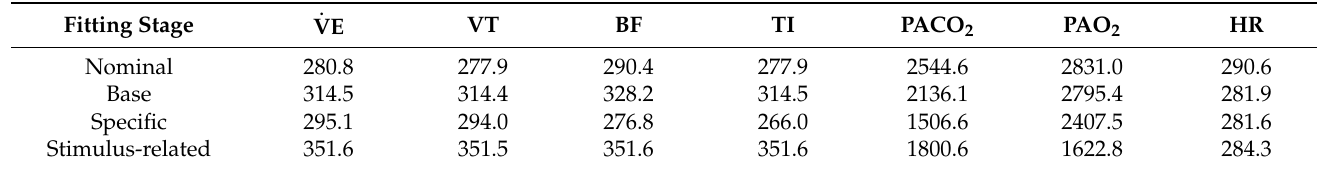
Table 7. Settling time (seconds) of the model predictions for each fitting